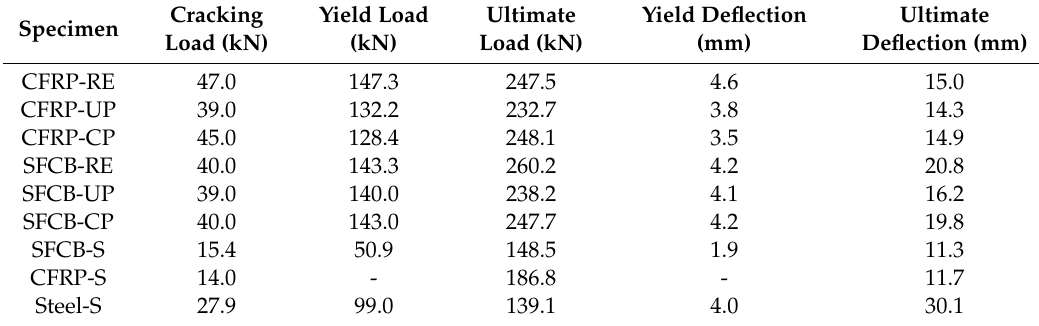
Table 5. The result of the load capacity for the test